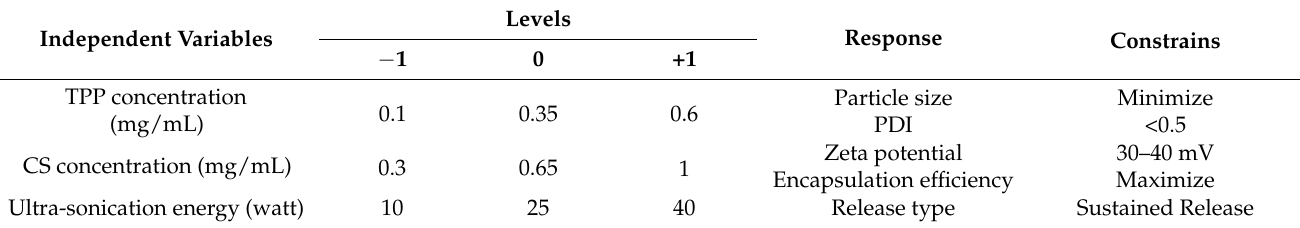
Table 2. List of independent variables and responses used in the